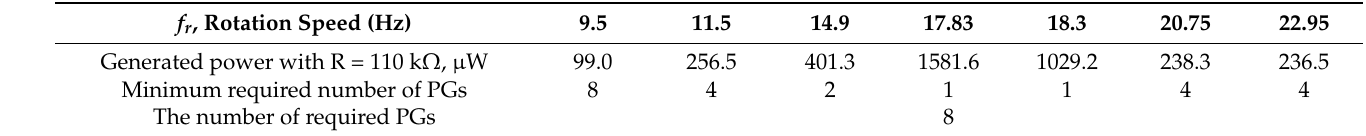
Table 4. The required number of PGs for autonomous wireless data transfer using the standard PG configuration.